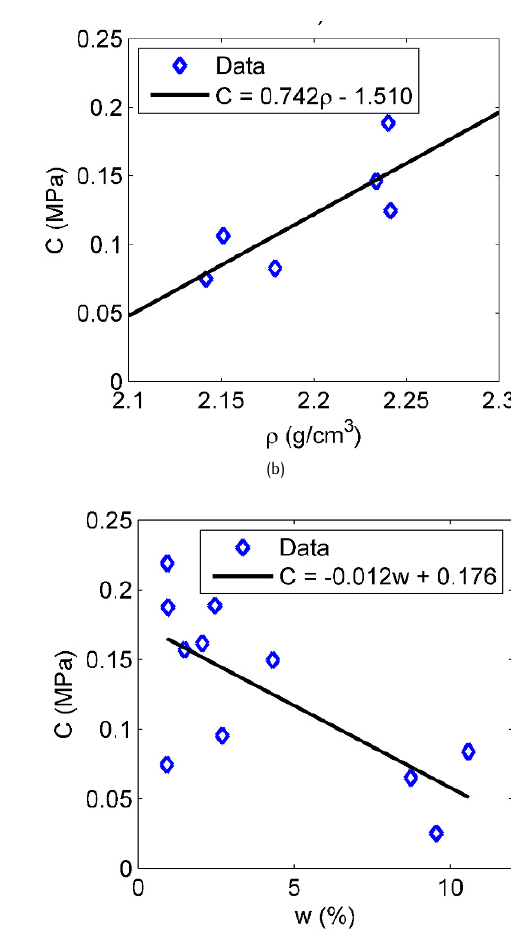
negative x-direction according to Figure 6. The